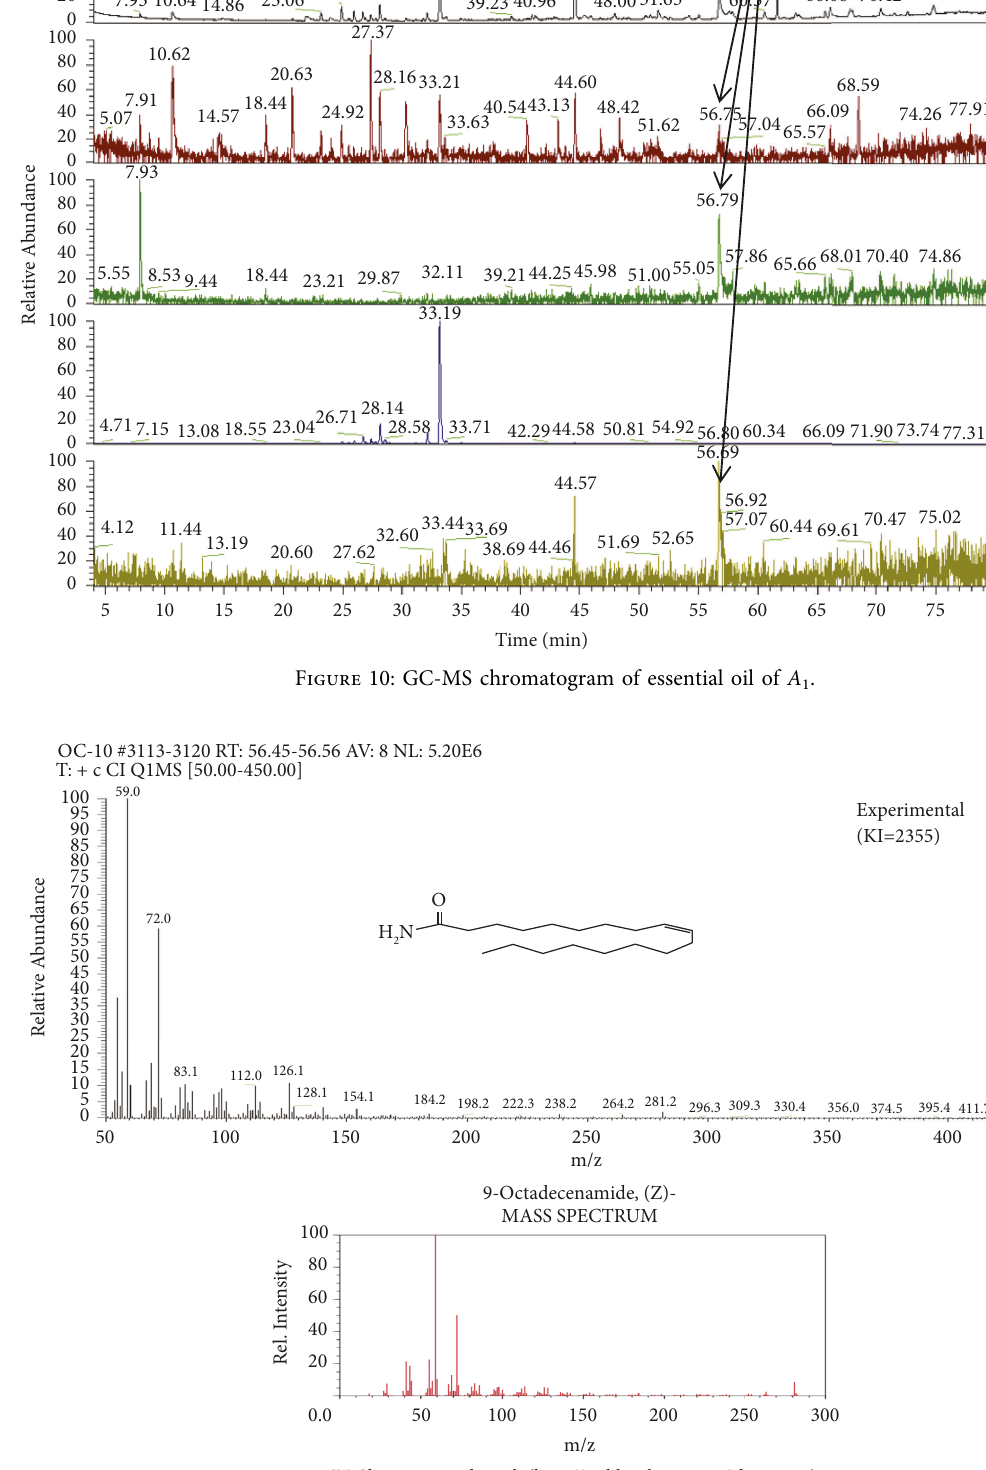
Figure 11: Mass spectra of